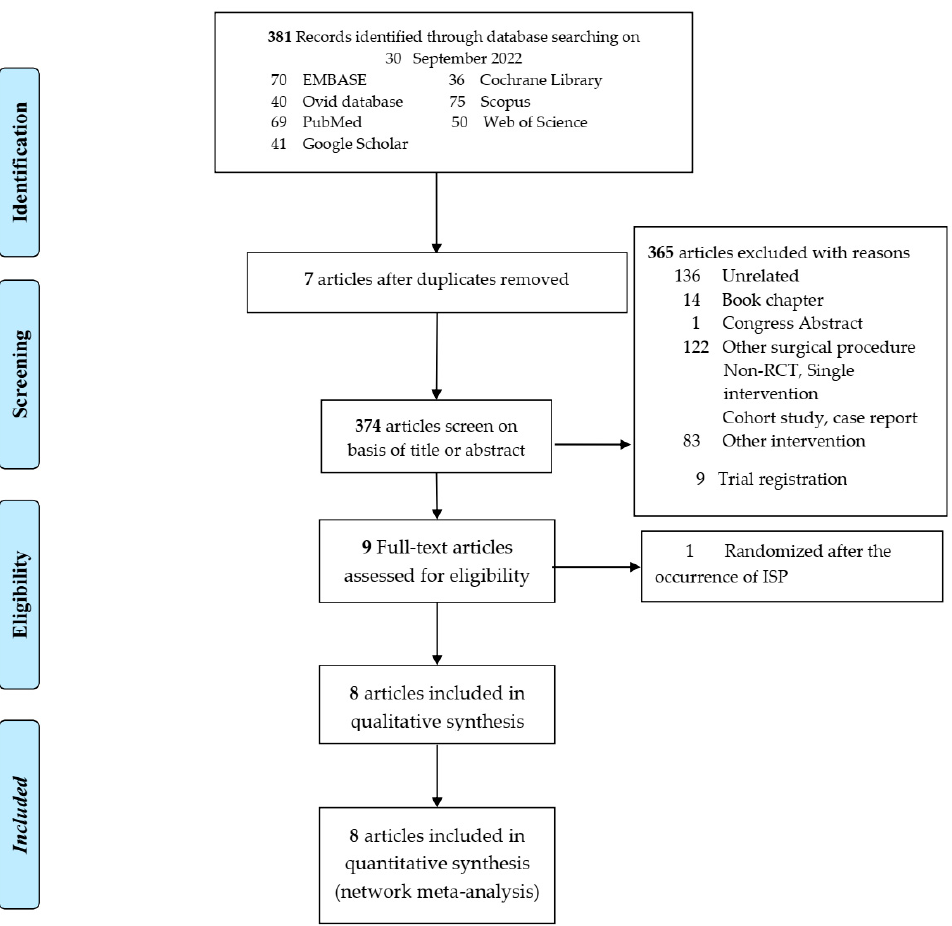
Figure 1. PRISMA flow diagram of selected articles.